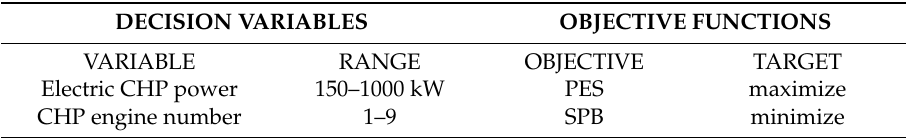
Table 1. Decision variables and objective functions of the optimization problem. SPB: simple payback